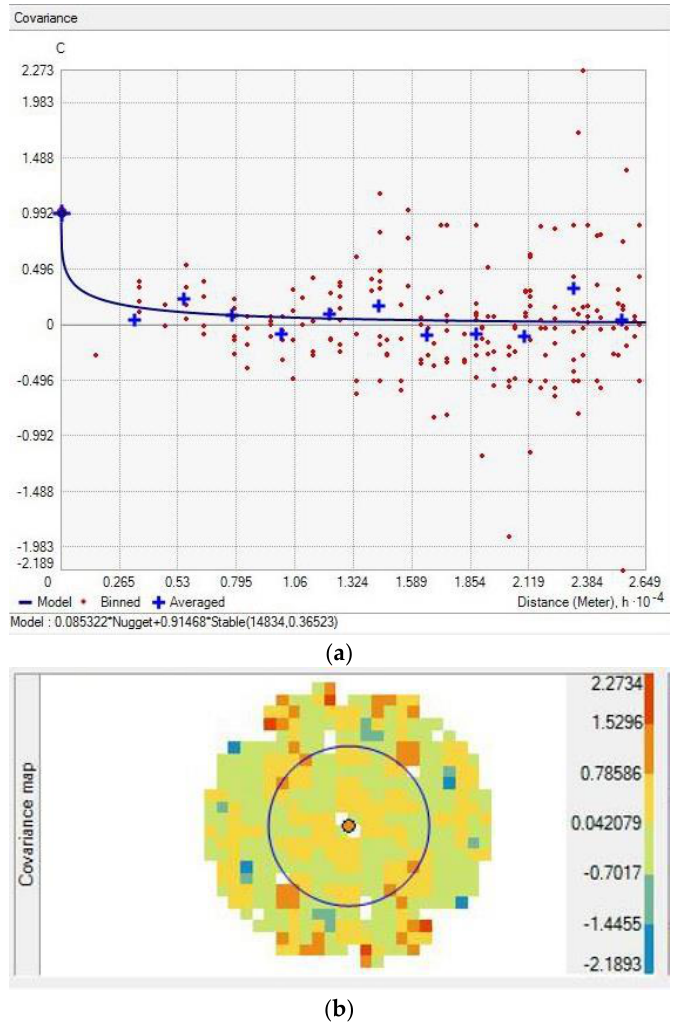
Figure 8. ( a ) Semivariogram model and ( b ) covariance map of Kriging method.